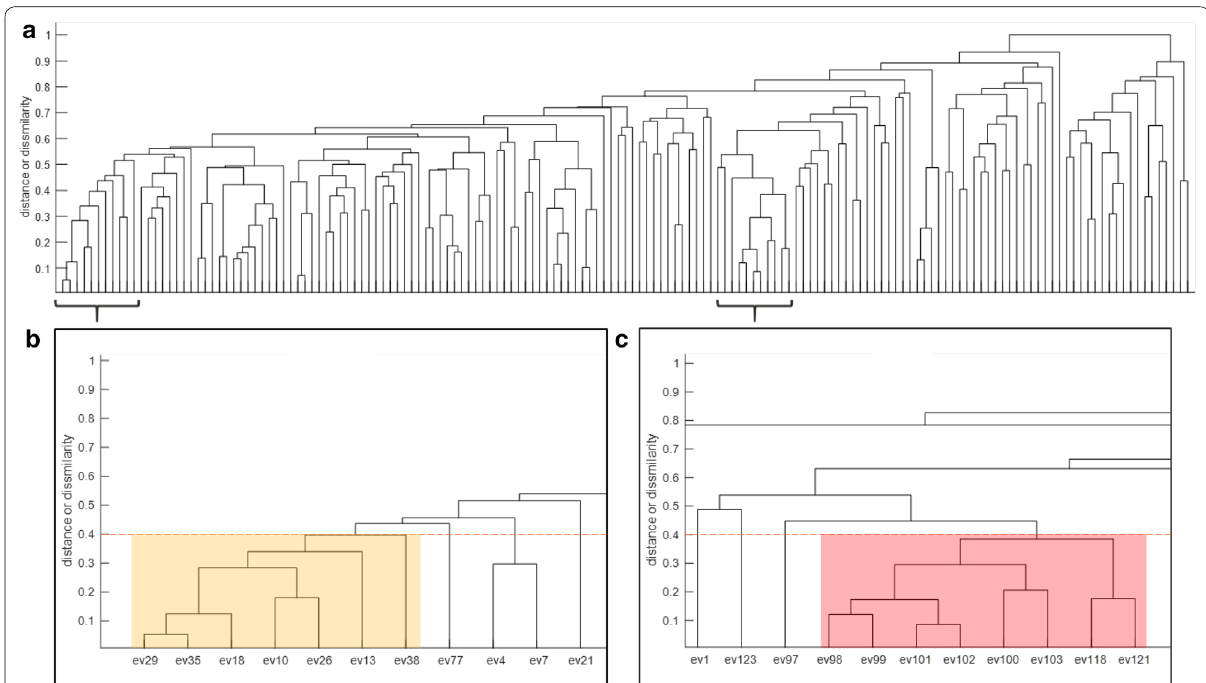
Fig. 4 A dendrogram of 159 events after hierarchical clustering ( a ), a basis of multiplet grouping, for example multiplet group A1 ( b ), and multiplet group B3 ( c ) are formed using a dissimilarity cut-off